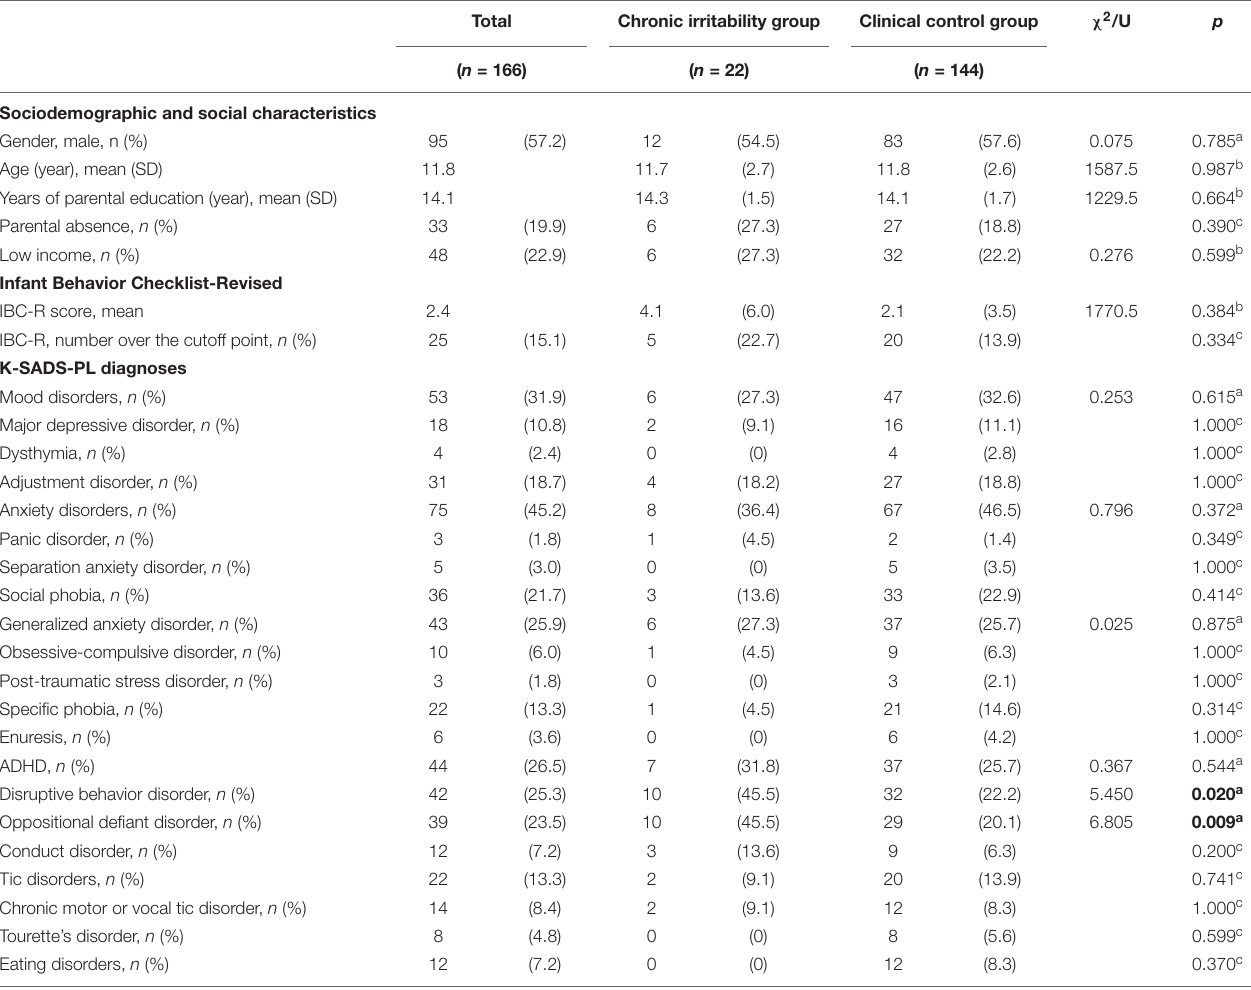
TABLE 1 | Participant sociodemographic and clinical